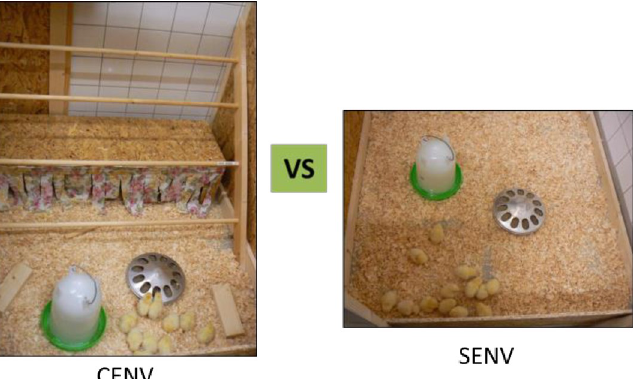
Fig 1. Complex versus simple environments. Photo of two pens from the current experiment; the one on the left side represents the Complex Environment (CENV) treatment provided with a drinker, a feeder, wood shavings, three wooden blocks, four perches at different levels and a hide area; while the one on the right side represents the Simple Environment (SENV) treatment, provided only with a drinker, feeder and wood shavings.